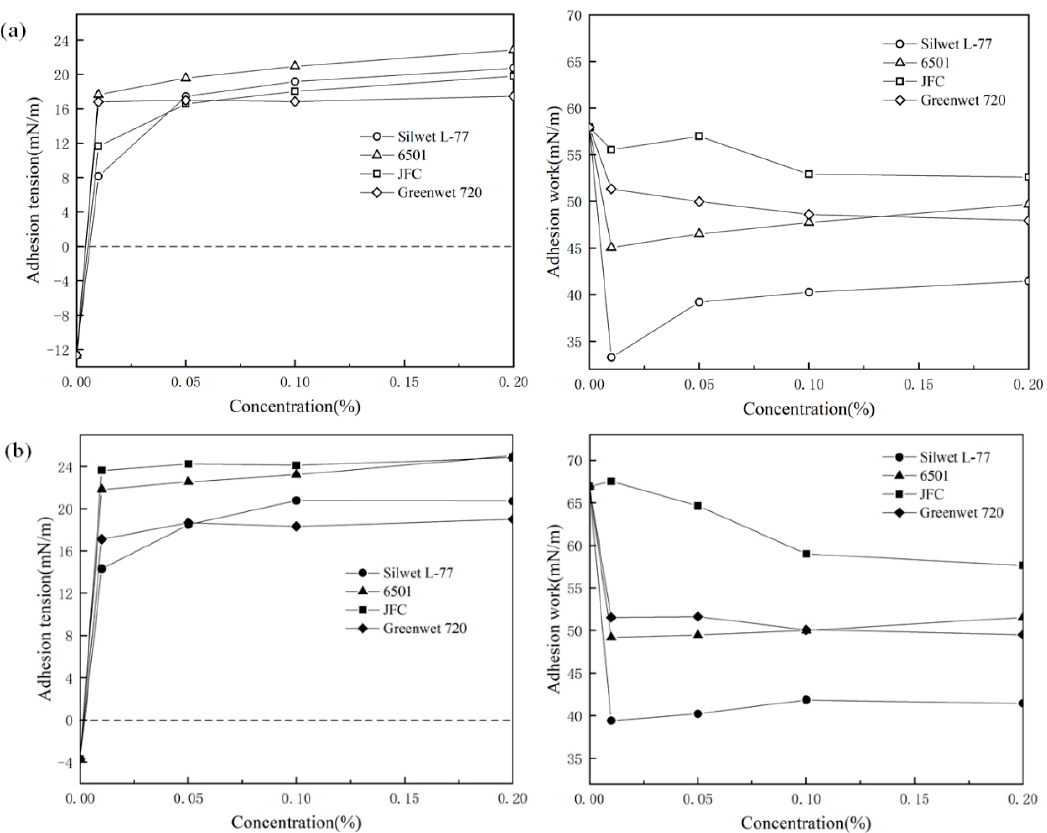
Figure 7. Adhesion tension and adhesion work of bifenthrin droplets with different adjuvants on the surfaces of the fresh bud ( a ) and young leaf ( b ) vary with the concentration.